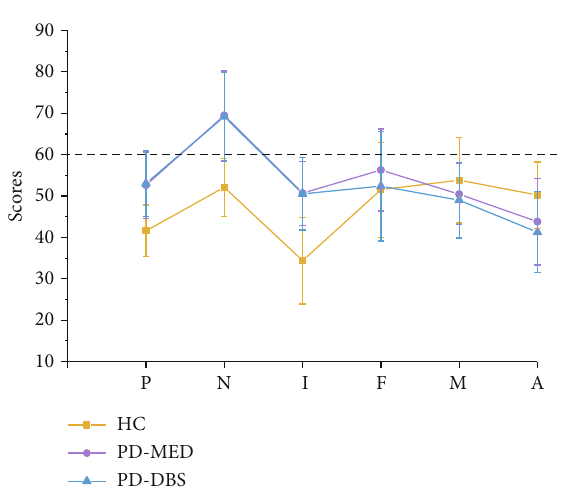
Figure 2: Scores of clinical factors in three groups of subjects. Note: P: including positive loads of F, PA, Pt, Ma, and SC and negative loads of L; N: including Hs, Hy, and D; I: including Pt, D, Si, F, Pa, M, and Mf; A: including high negative loads of Pd and medium negative load of